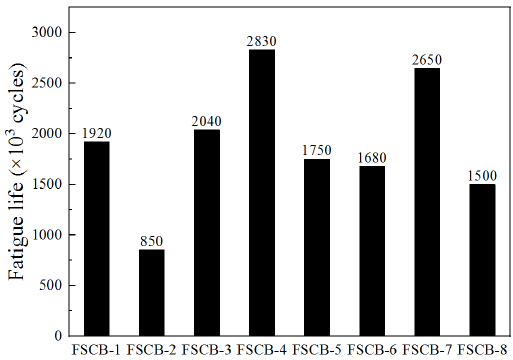
Figure 8. Fatigue life of specimens.